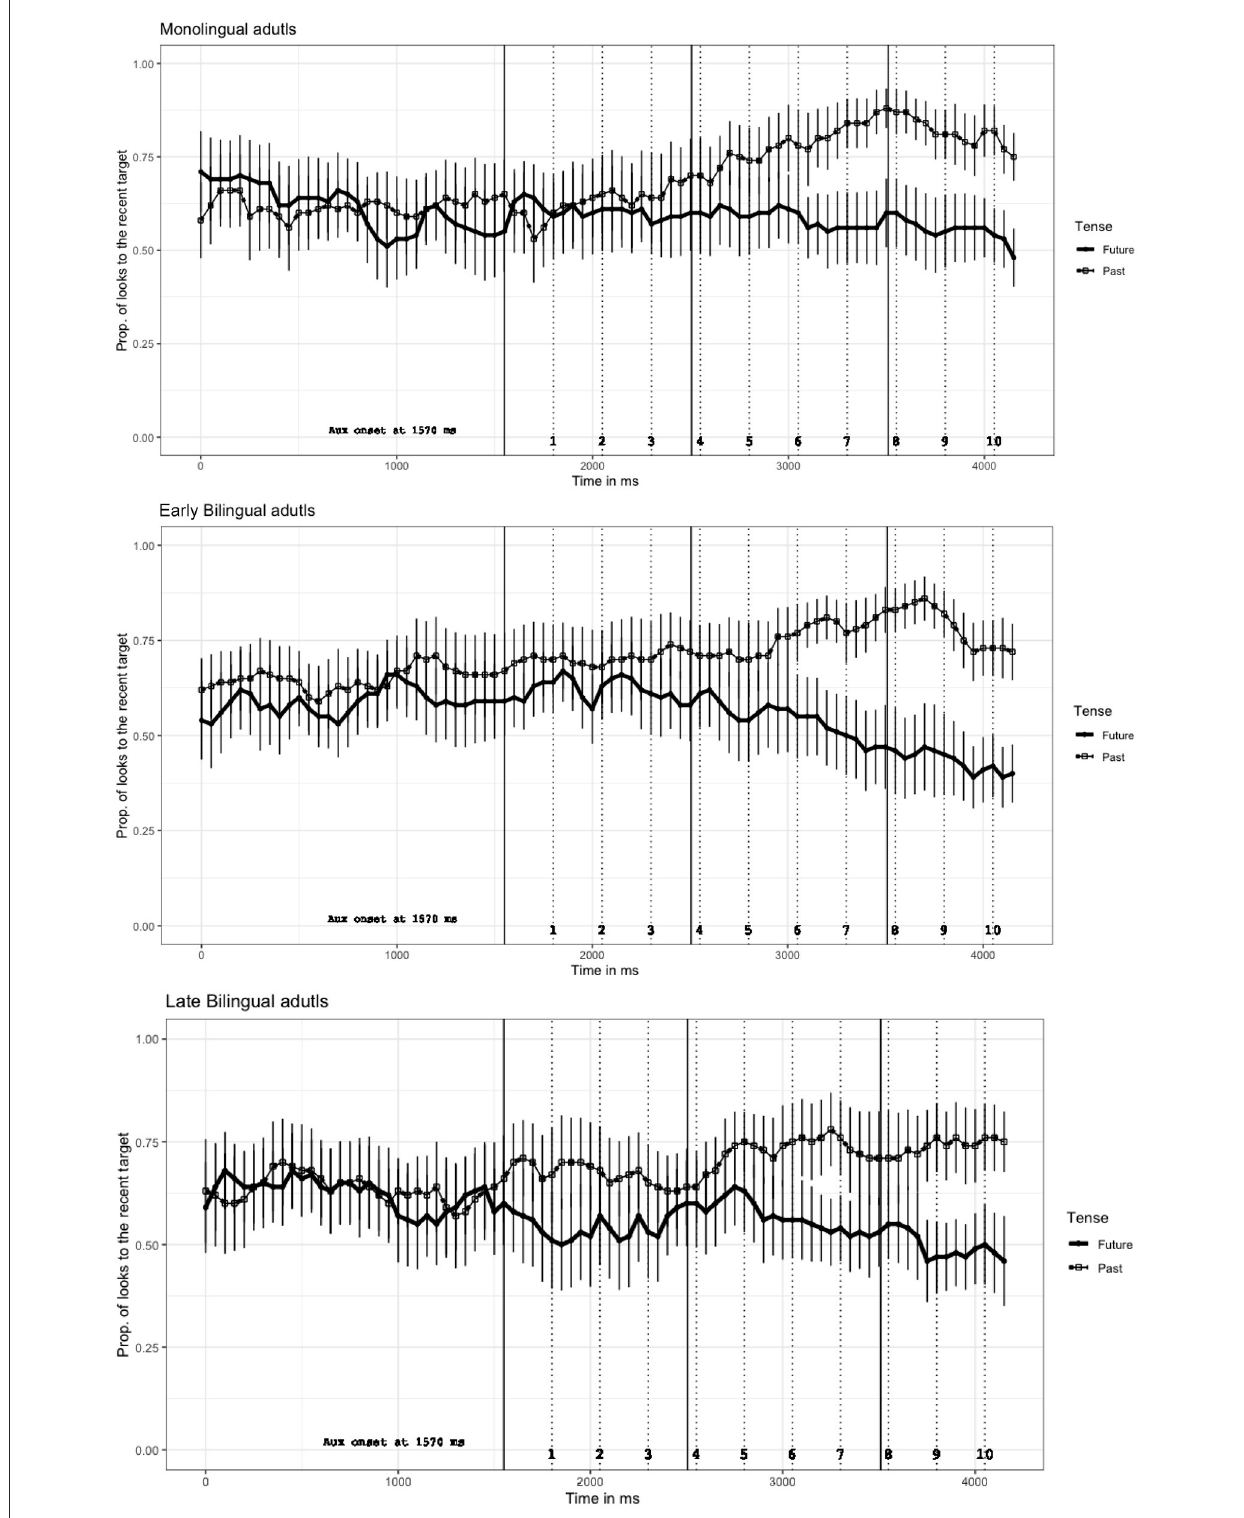
FIGURE3 Mean proportion (with SE ) of looks to the recent target depending on the sentence tense in Experiments 1 (monolinguals), 2, and 3 (bilinguals). Note that looks to the future target were complementary to the looks to the recent target.